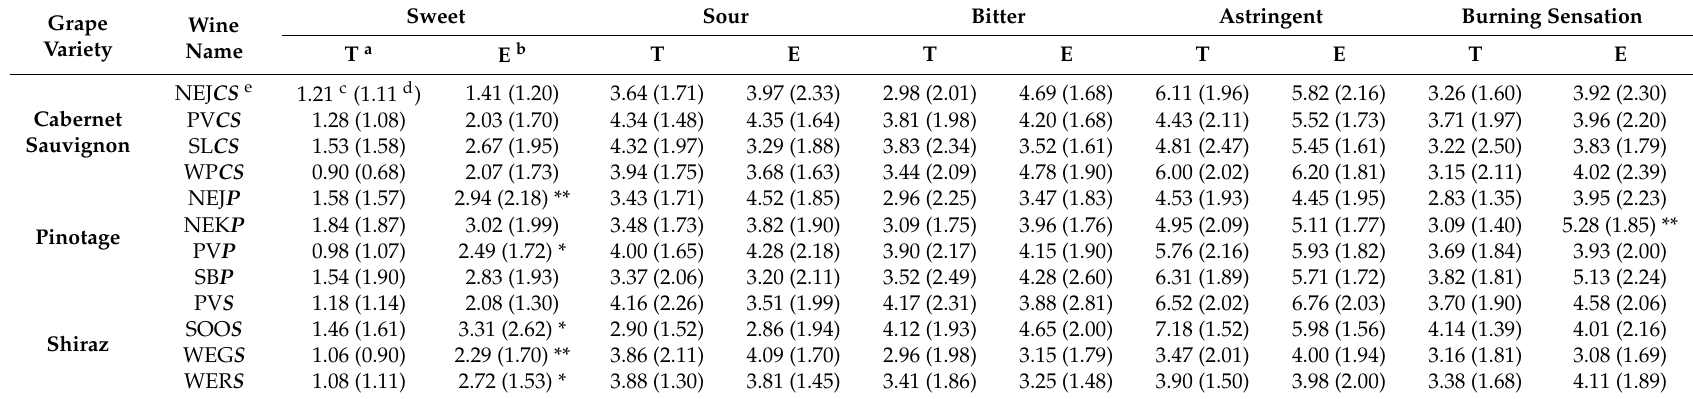
Table 3. Means, standard deviation, and results of analysis of variance (ANOVA) for the two panels in the “varietal” tasting modality.